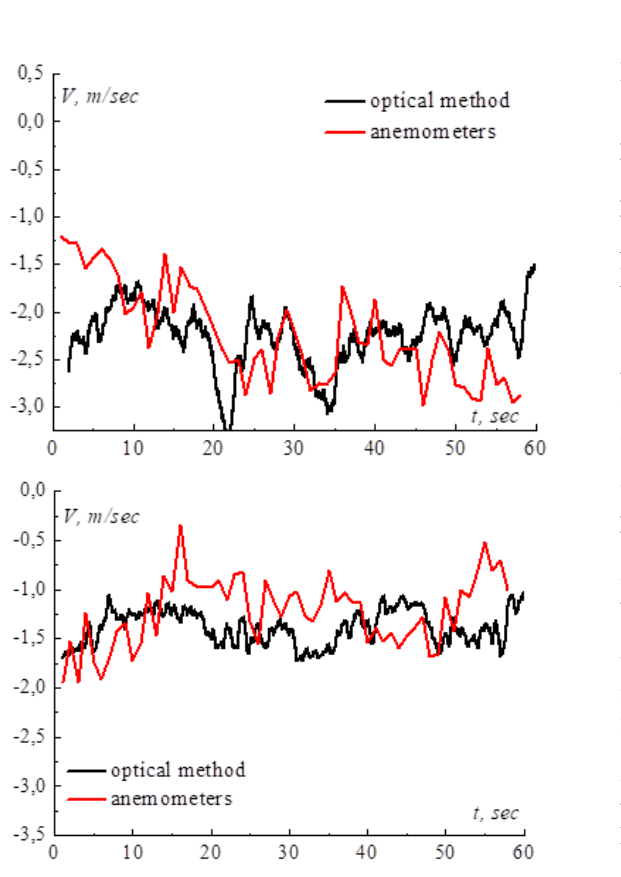
Fig. 4. Dynamics of the (a) retrieved wind speed near the observer (black curve) and (b) wind speed averaged over the central path segment in comparison with contact measurements by 10 acoustic anemometers equispaced along the path (red